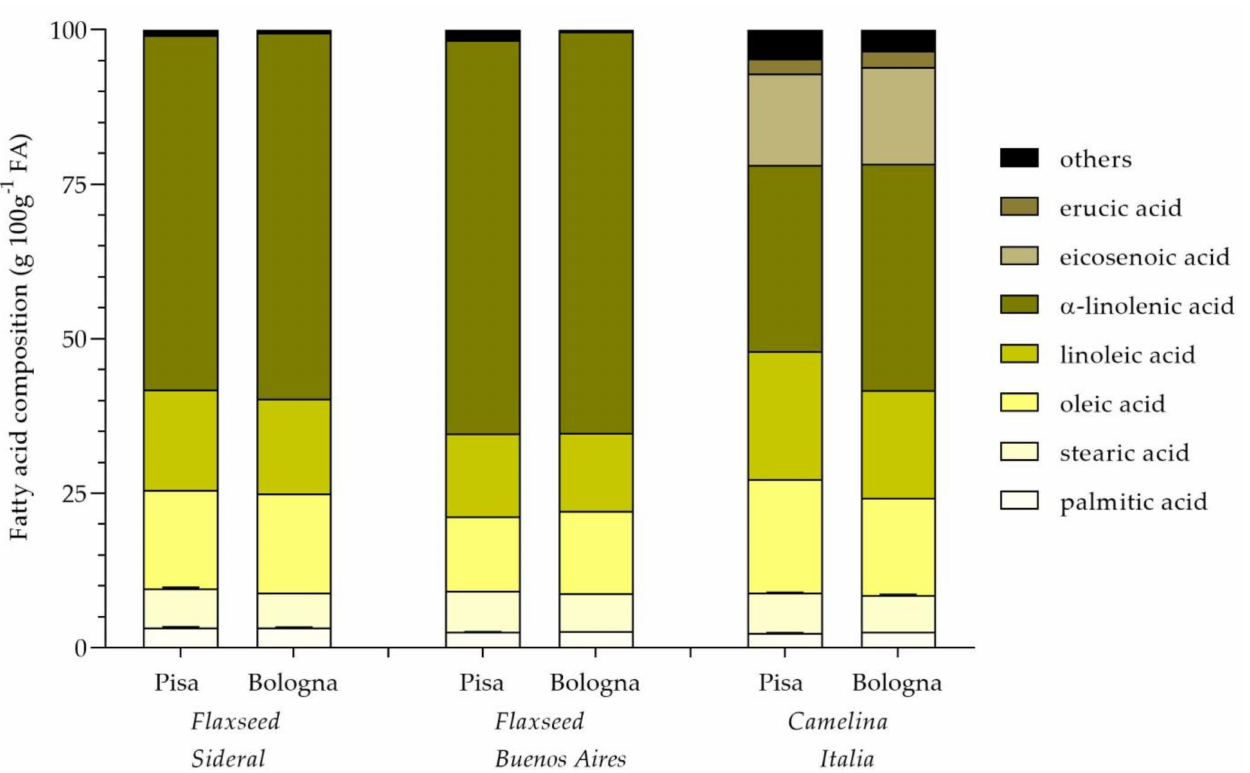
Figure 2. Fatty acid composition of oils of flaxseed (Sideral and Buenos Aires) and camelina (Italia) grown in two cultivation sites (Pisa and